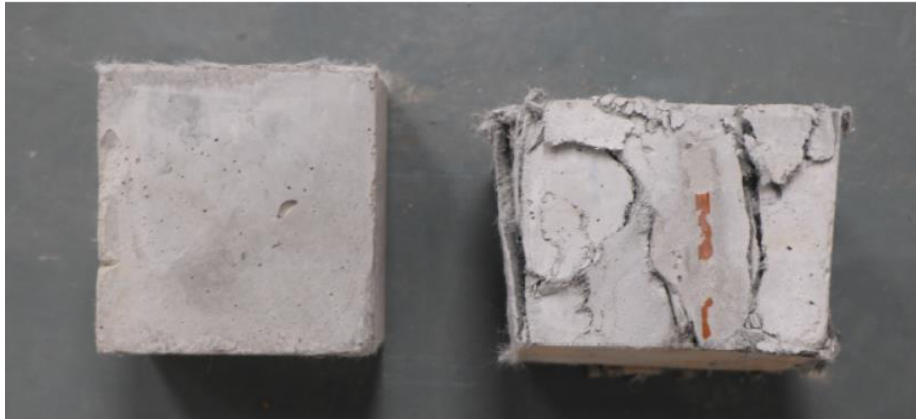
Figure 7: Failure mode comparison of ECC cube specimens in different phases of loading.